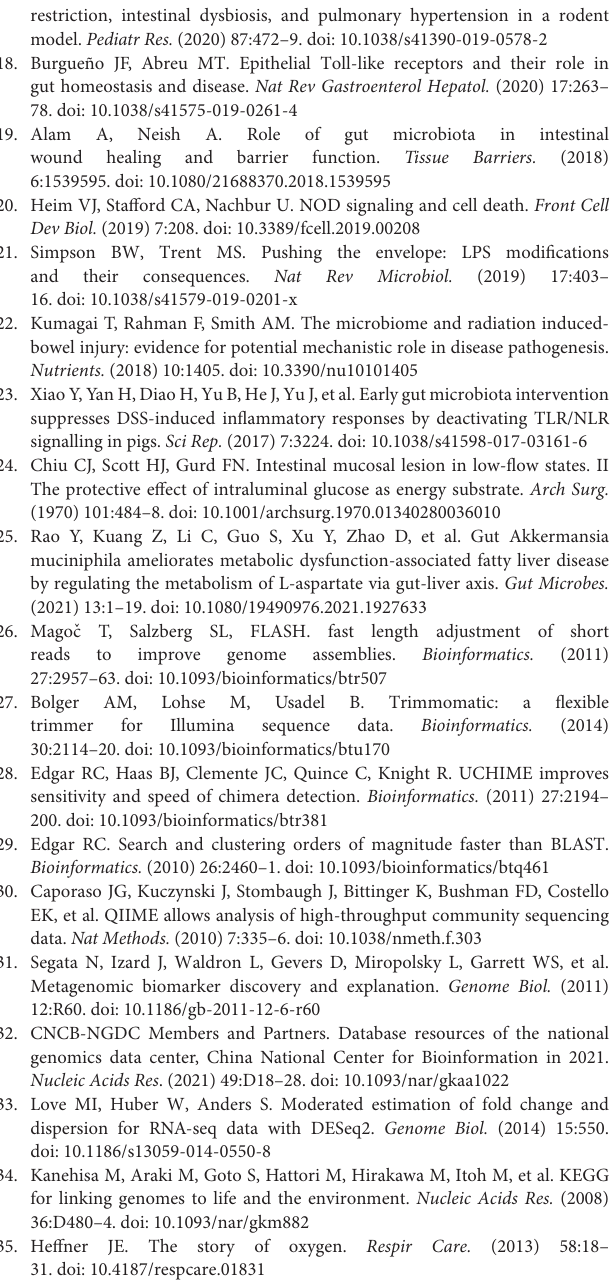
Supplementary Table 2 | ANOVA analysis of time- and dose-dependent gut cell death induced by hyperoxia. Supplementary Table 3 | ANOVA analysis of time- and dose-dependent gut barrier dysfunction and endotoxemia by hyperoxia. Supplementary Table 4 | ANOVA analysis of time- and dose-dependent gut inflammation and oxidative stress induced by hyperoxia. Supplementary Table 5 | KEGG enrichment analysis of gut injury induced by